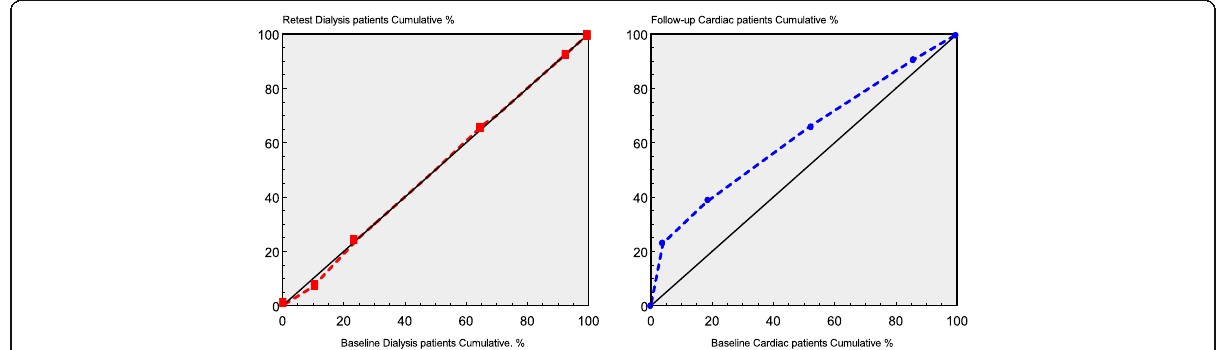
Fig. 1 ROC-curve for dialysis patients and cardiac rehabilitation patients illustrating the change in the Health change item between the two measurements. The curves present the cumulative marginal distribution and show no differences for the dialysis patients, but an increase in patients with better health now than a year ago for the cardiac rehabilitation